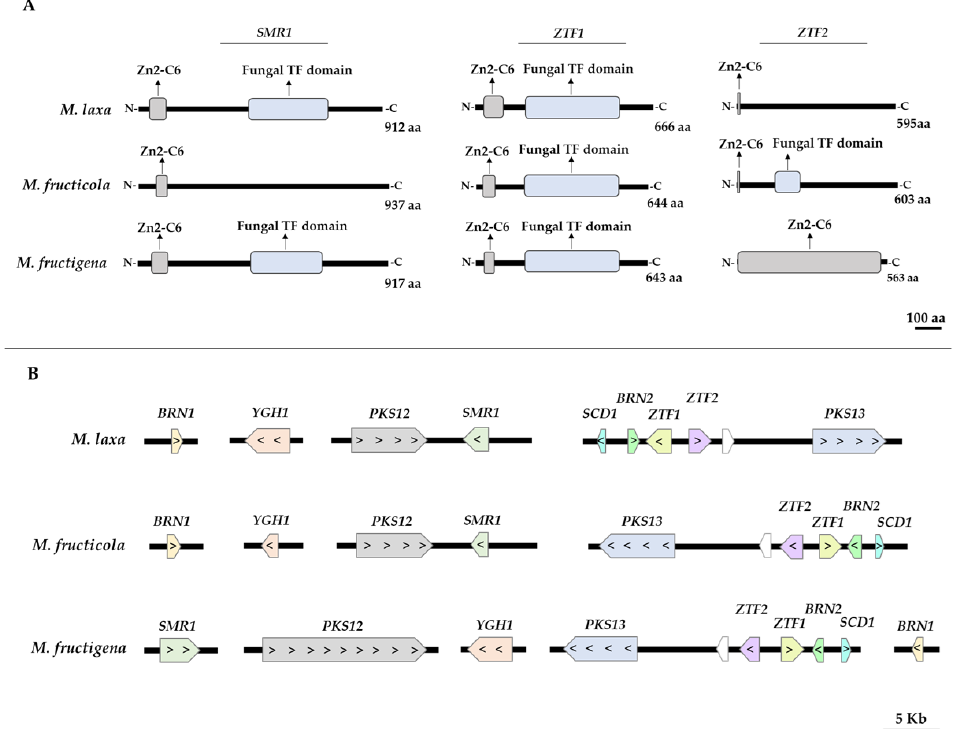
Figure 1. ( A ) Domain architecture of the regulatory genes SMR1 , ZTF1, and ZTF2 of the three Monilinia spp. involved in the DHN-melanin pathway. ( B ) Distribution of the DHN-melanin related genes in the genomes of Monilinia spp.